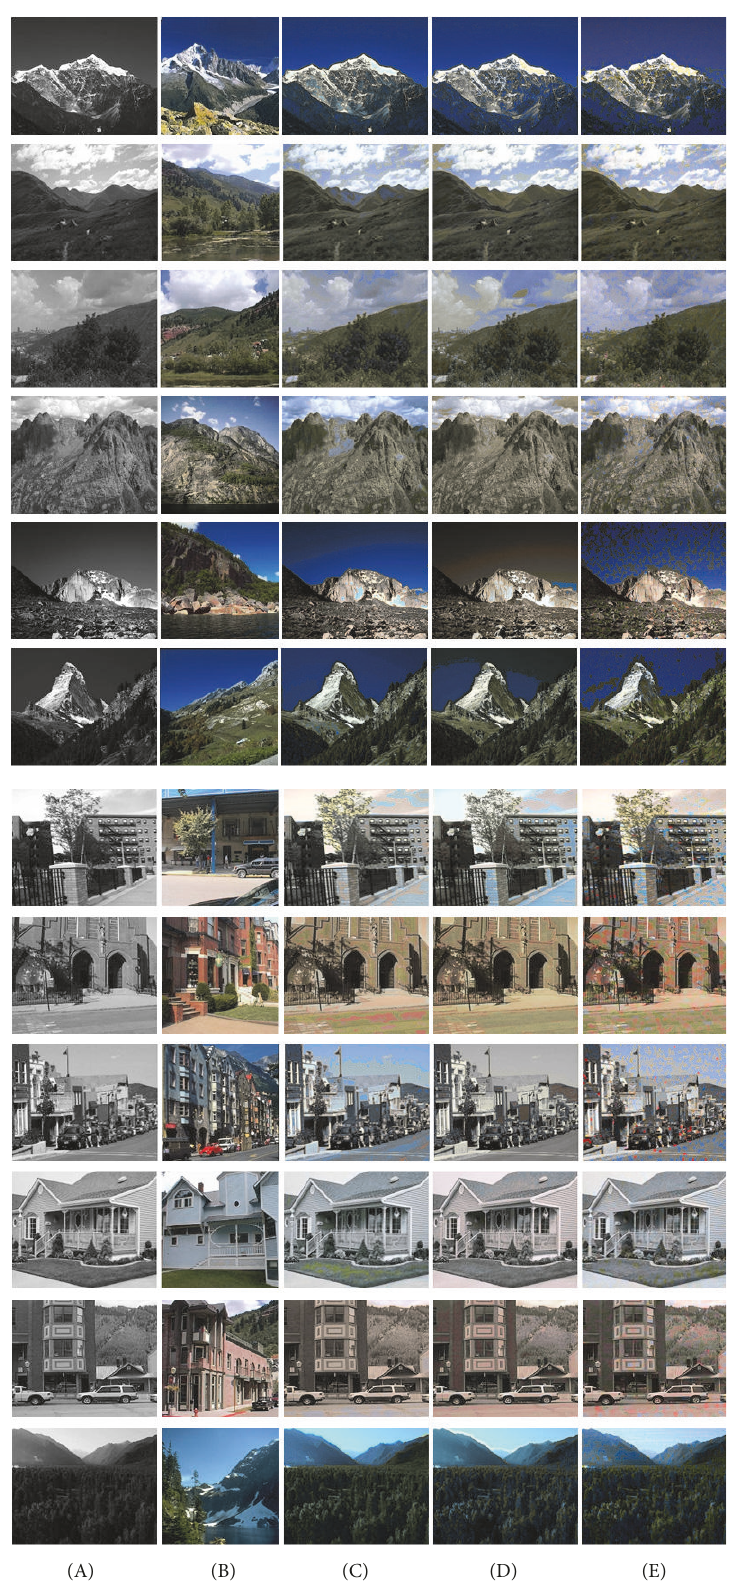
Figure 7: The outputs colorized images using our learned feature (C), Feature Line (D), and superpixel (E) method. Output images from our method contain less defects and more even than other two